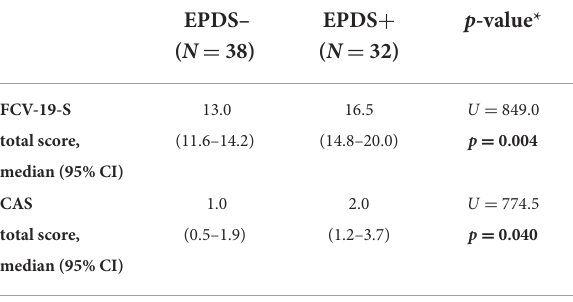
TABLE 4 Psychopathological differences according to the EPDS screening.